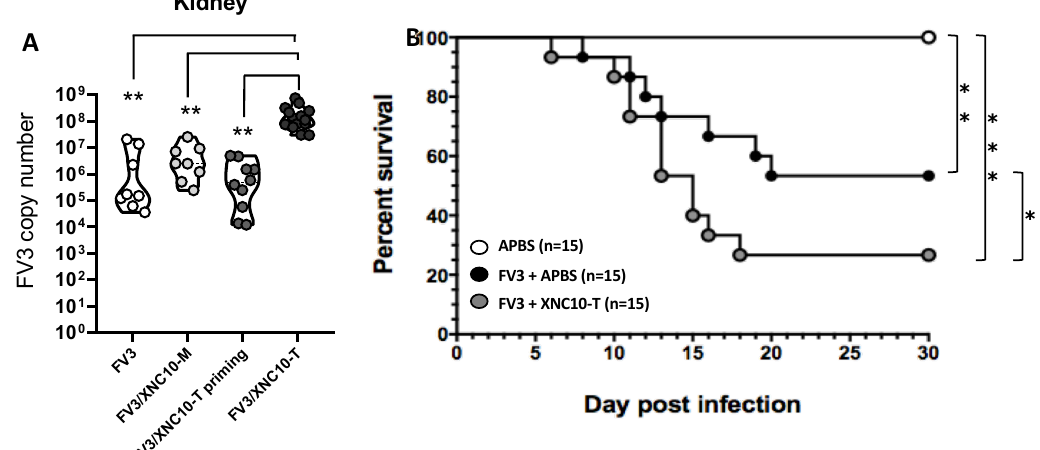
Figure 5. Specificity and long term impact of transitory iV α 6T cell depletion. ( A ) Three week-old (stage 55) tadpoles were injected with either 1 µ g XNC10-tetramers (FV3 / XNC10-T), 1 µ g XNC10-monomers (FV3 / XNC10-M), or vehicle control (FV3 / APBS) 1 day pre and 1 day post i.p. infection with 10,000 PFUs of FV3 ( n = 8), and kidneys were collected at 6 dpi. The last group (FV3 / XNC10-T priming) was first injected with 1 µ g XNC10-tetramers, then 3 days later infected with FV3, and kidneys were collected at 6 dpi. Viral loads were assessed by absolute qPCR with primers against FV3 polymerase II. The results are combined from two separate experiments, and each dot represents an individual tadpole; ** p < 0.01 above the line denotes statistically significant di ff erences between the indicated groups (One way ANOVA followed by Tukey’s multiple comparison test). ( B ) Three week-old (stage 55) tadpoles were injected with either 1 µ g XNC10 tetramers (FV3 / XNC10-T) or vehicle control (FV3 / APBS) 1 day pre, and 1 day post were i.p injected with 10,000 PFUs of FV3 ( n = 15) and survival was monitored daily over a 30-day period. Survival was determined using Kaplan-Meier, * p < 0.05, ** p < 0.005, and *** p < 0.0005. Uninfected controls (white circle), FV3 infected tadpoles (black circle), and XNC10 tetramer treated FV3 infected tadpoles (grey